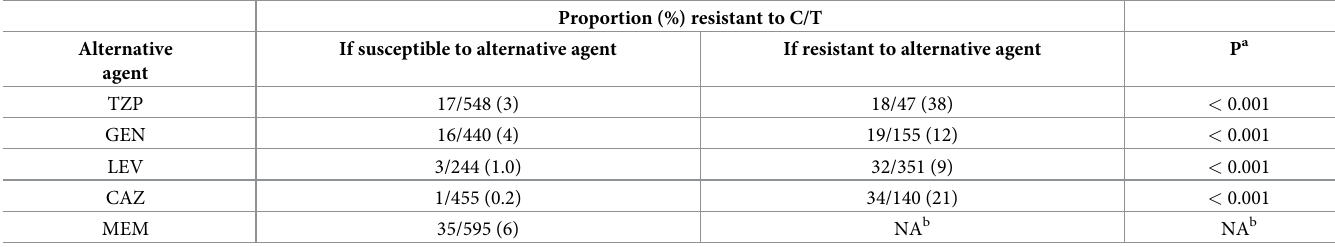
Table 4. Prevalence of resistance to ceftolozane/tazobactam among Escherichiacoli clinical isolates susceptible or resistant to alternative